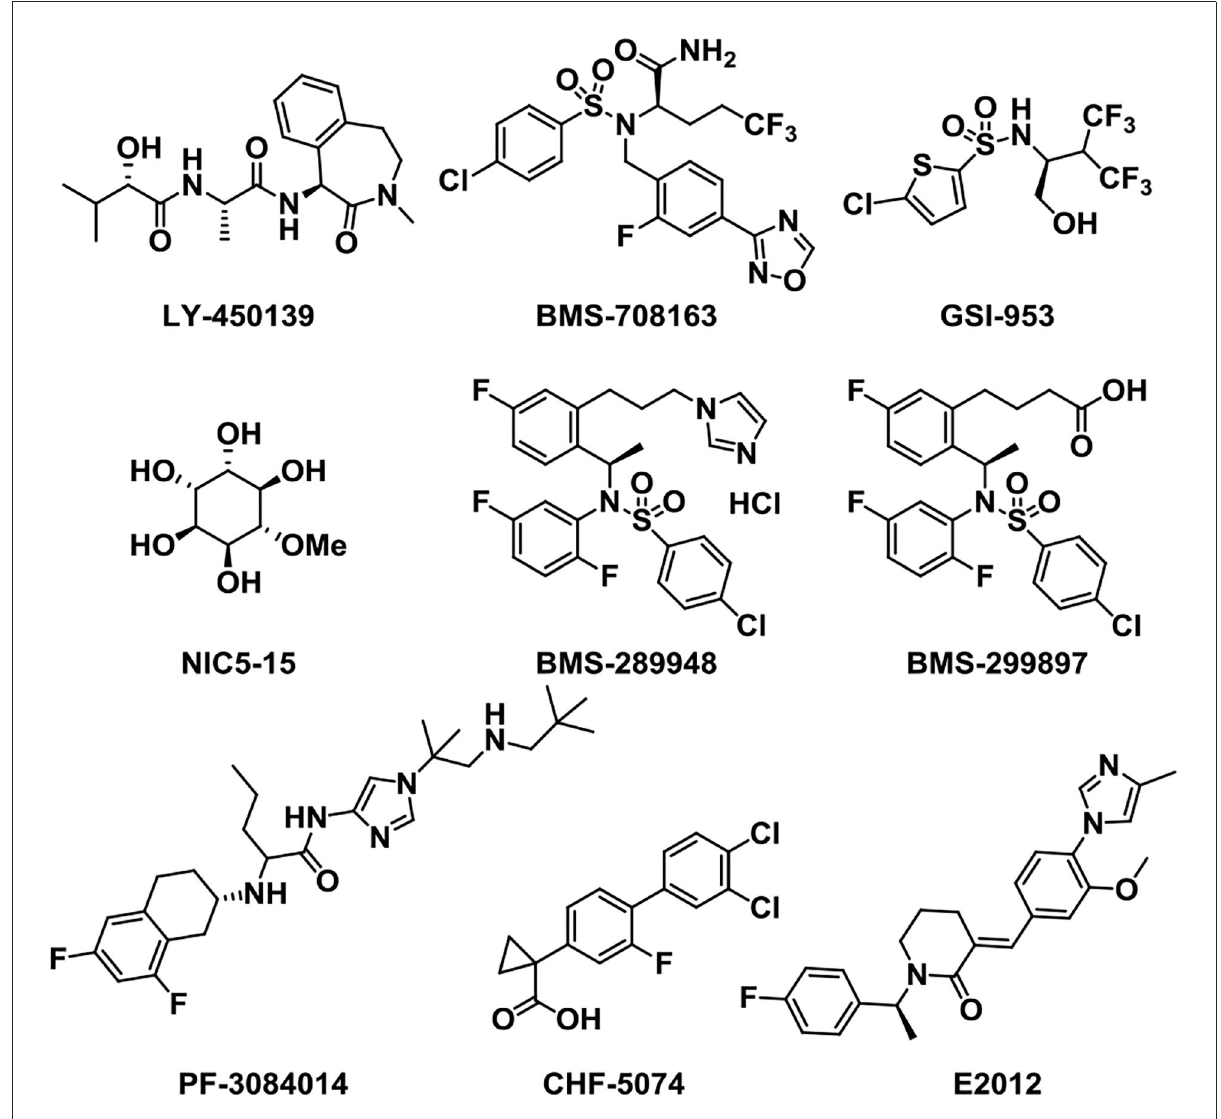
FIGURE7 Structures of γ -secretase inhibitors and